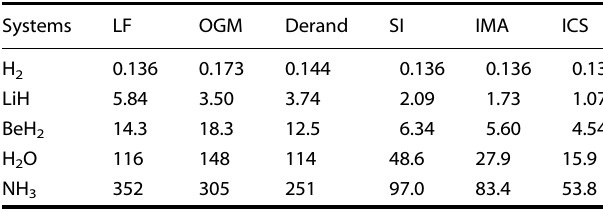
Table 2. Number of optimization variables. Table 3. Variances with qubit wise commuting fragments.